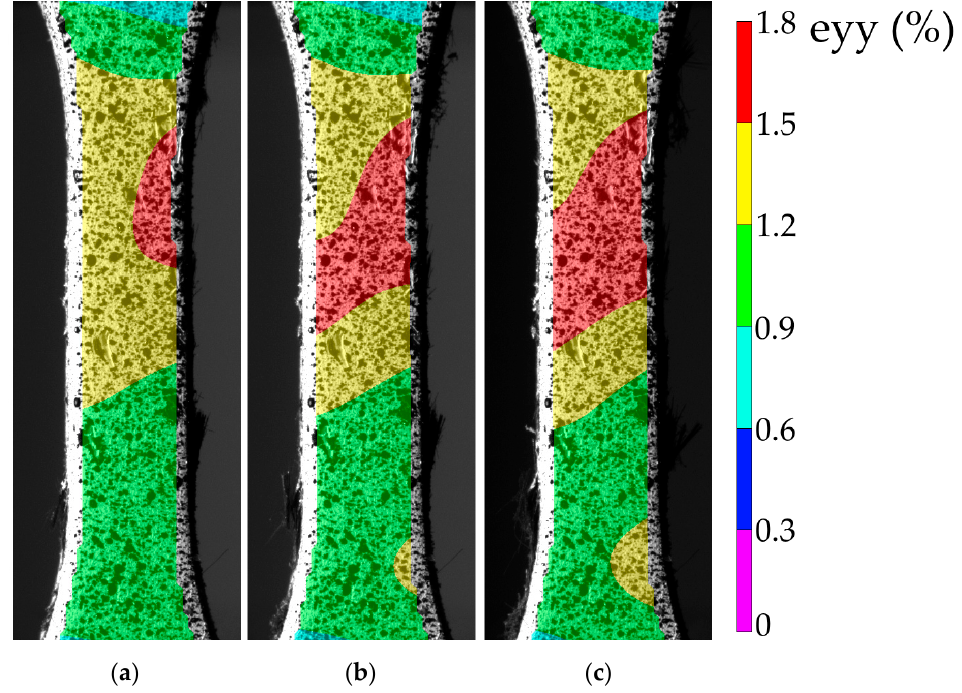
Figure 12. The strain development in the LCF tests: 1000 ( a ); 3000 ( b ); 7000 cycles ( c ).